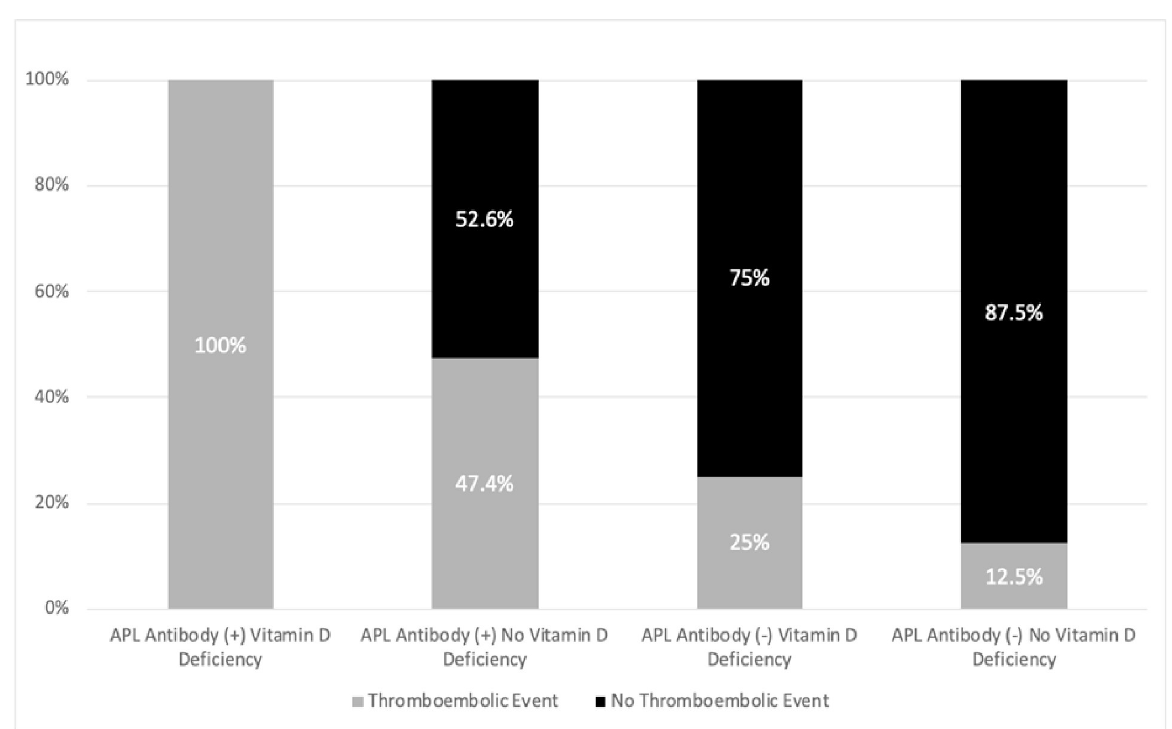
PLOS ONE | https://doi.org/10.1371/journal.pone.0269466 July 14,